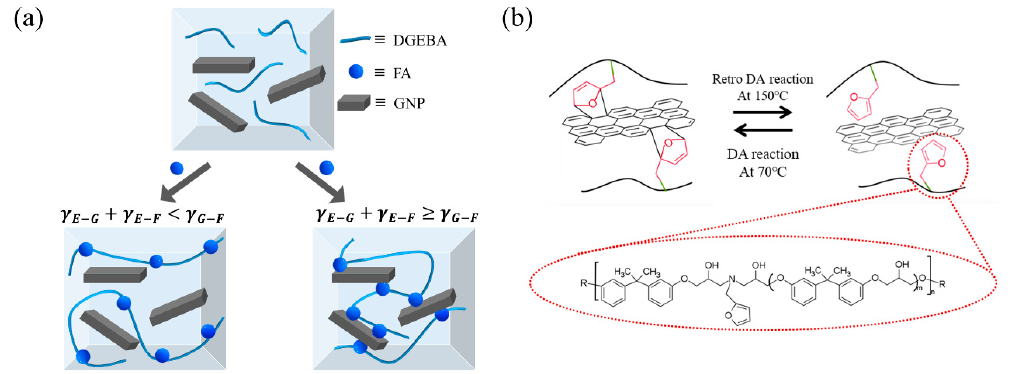
Figure 2. Schematics of two different dispersion behaviors in the system ( a ), and Diels-Alder (DA) and retro DA reactions between the GNPs and furfurylamine (FA) in the graphene-nanoplate/epoxy (GNP/EP) composites ( b ). Table 1. Interfacial tension between the constituents of the GNP/EP nanocomposites.